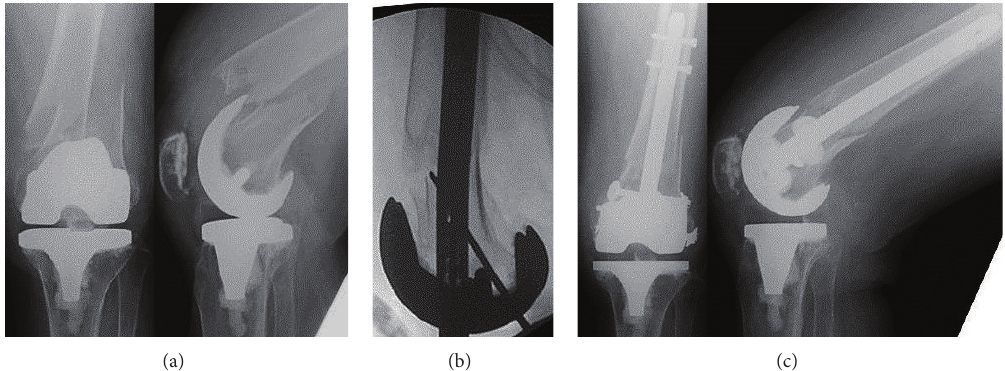
Figure 1: (a) Radiographs of the left displaced periprosthetic supracondylar fracture. (b) A 2.4 mm block pin inserted on the lateral side of the distal fragment. (c) The nail inserted with excellent repositioning of the fracture